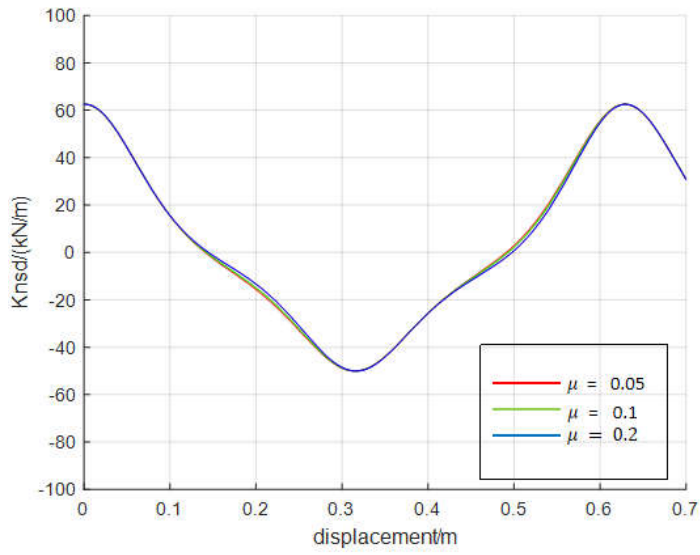
Figure 12. Influence of friction coefficient of track surface on negative stiffness.